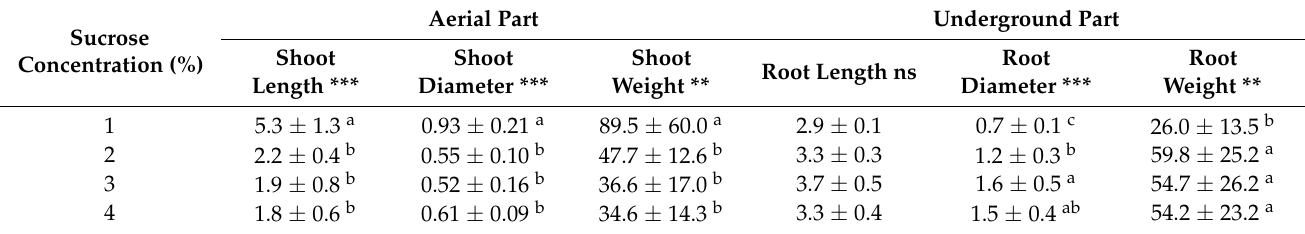
Table 5. Effect of sucrose concentration in the germination medium on the growth of shoots and